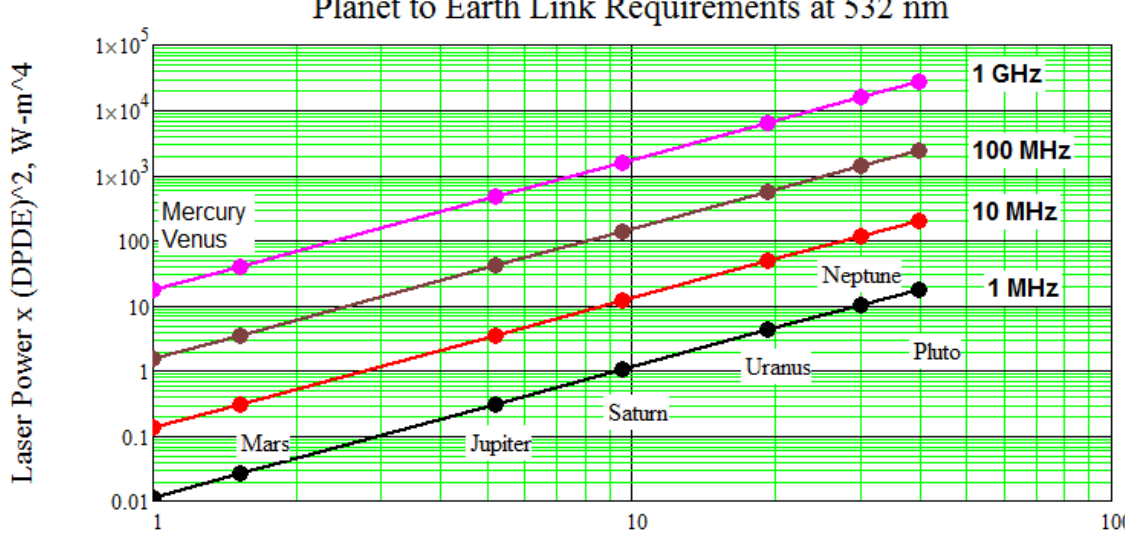
Figure 5. The product of the transmitted laser power emitted by the planetary probe and the two telescope diameters squared ( y -axis) is plotted as a function of the planetary distance ( x -axis) for a wavelength of 532 nm and four candidate bit rates: 1 MHz (black), 10 MHz (red), 100 MHz (brown), and 1 GHz (pink). The dots along the lines indicate the average distance of the planet from Earth, as listed in Table 1. The chart can be used for other wavelengths by multiplying the y -axis number by ( λ /532 nm) 2